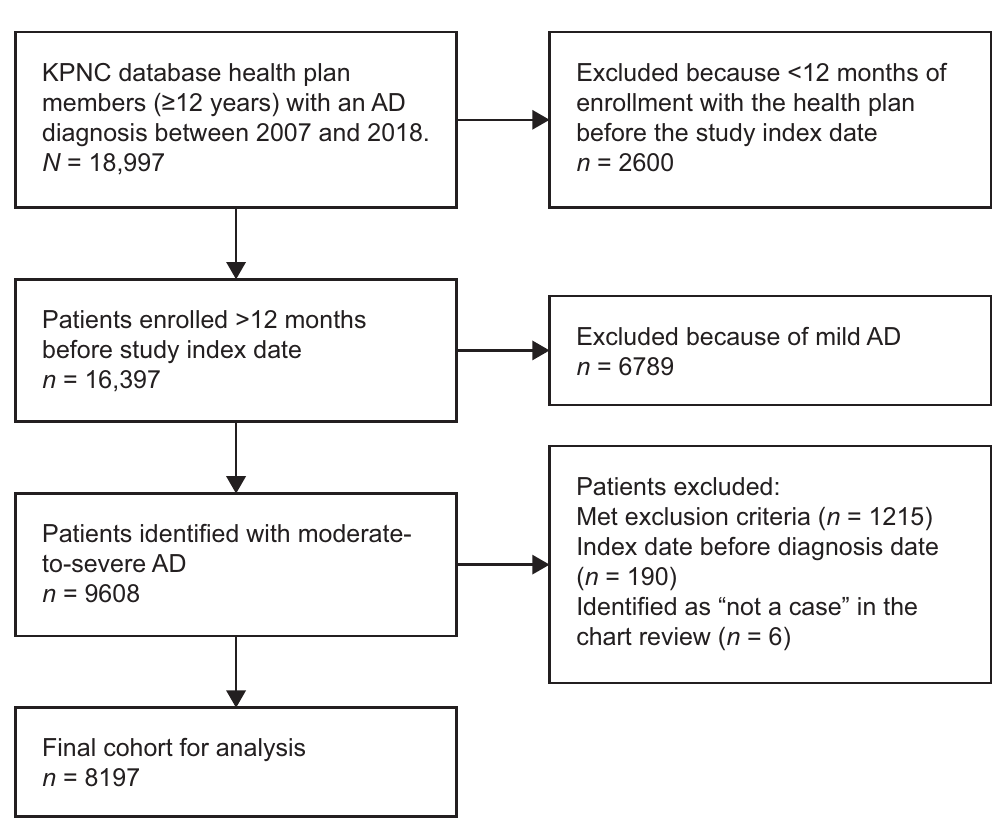
Fig 1. Cohort selection. AD, atopic dermatitis; KPNC, Kaiser Permanente Northern